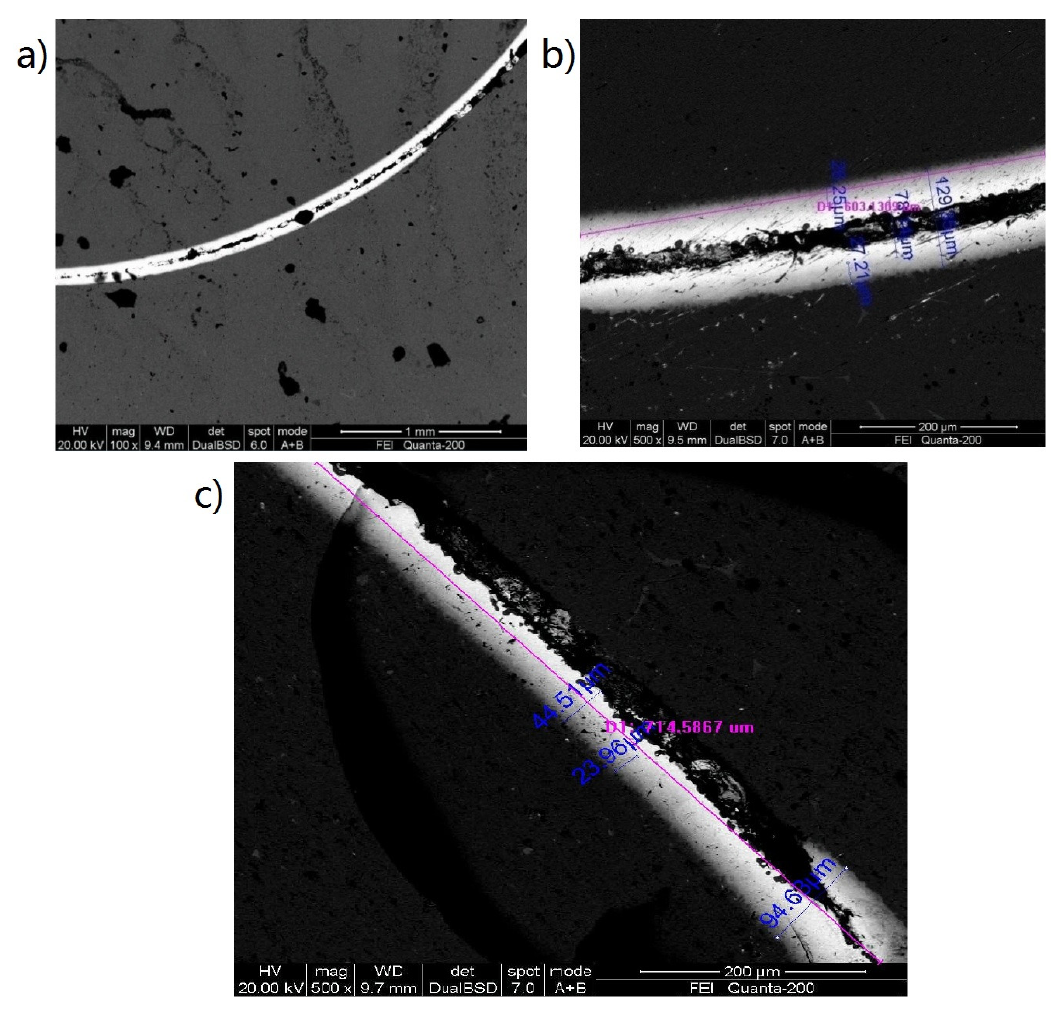
Figure 12. Cross-sectional SEM morphologies of micro defects for the sample brazed at 550 °C ( a ), low magnification view ( b ), and ( c ) micro voids.